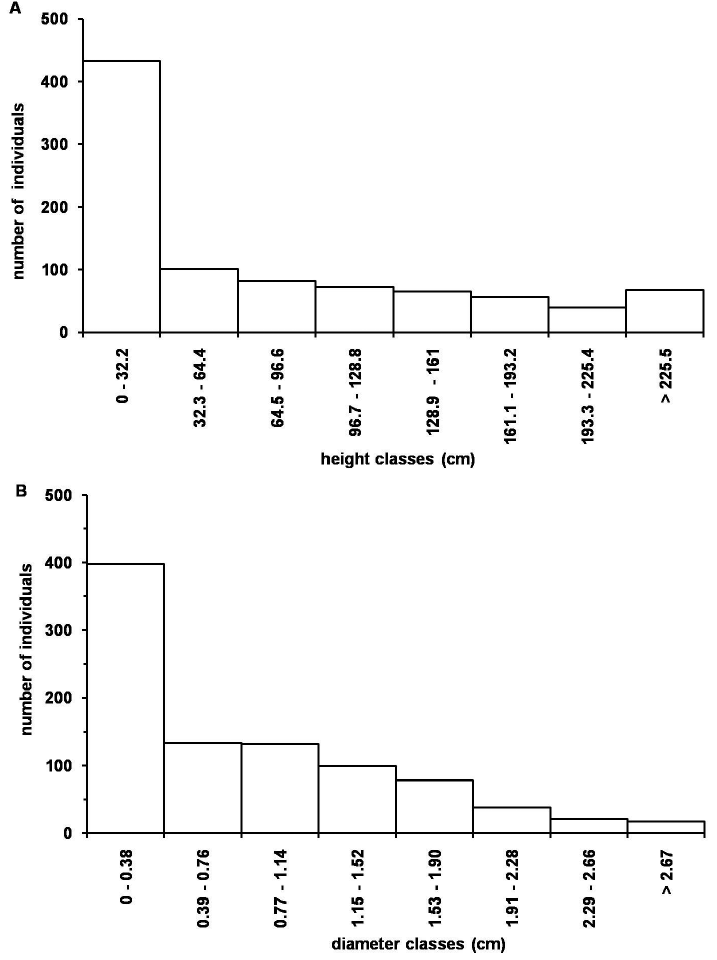
Fig. 1 – Number of individuals in height (a) and diameter (b) classes of a Rudgea parquioi- des (Rubiaceae) population in an Araucaria forest fragment in Curitiba, Southern